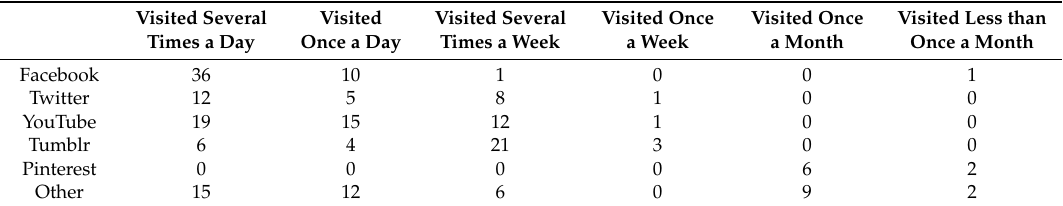
Table 2. Details of participants’ social media